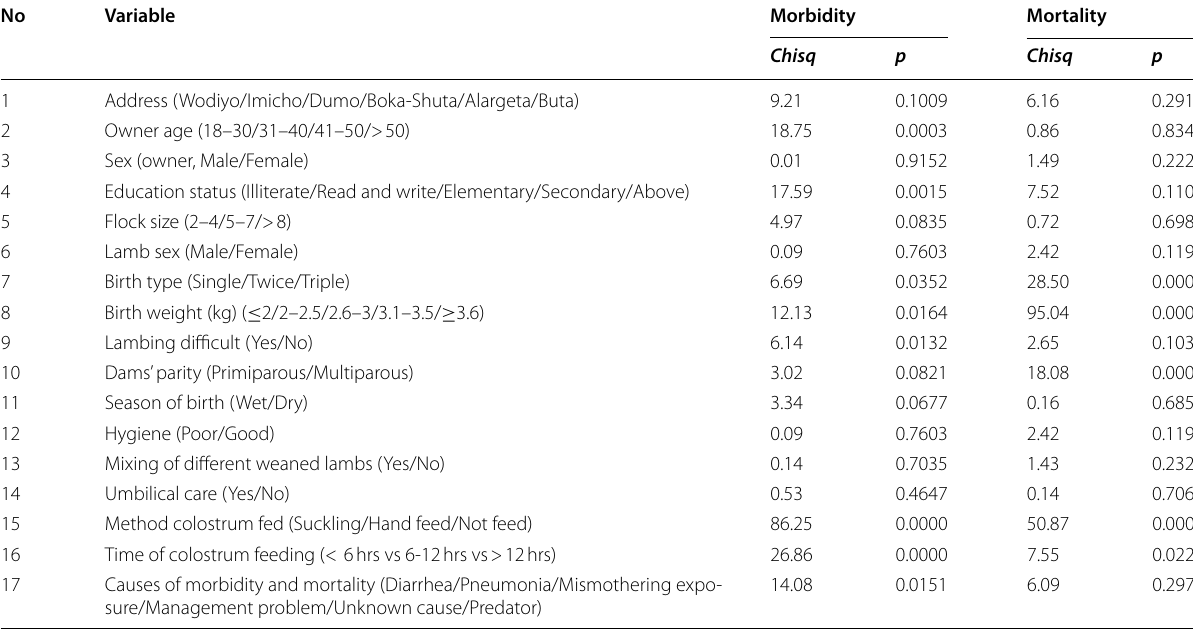
Table 5 Univariable analysis of risk factors for lamb morbidity and mortality using Log-rank test